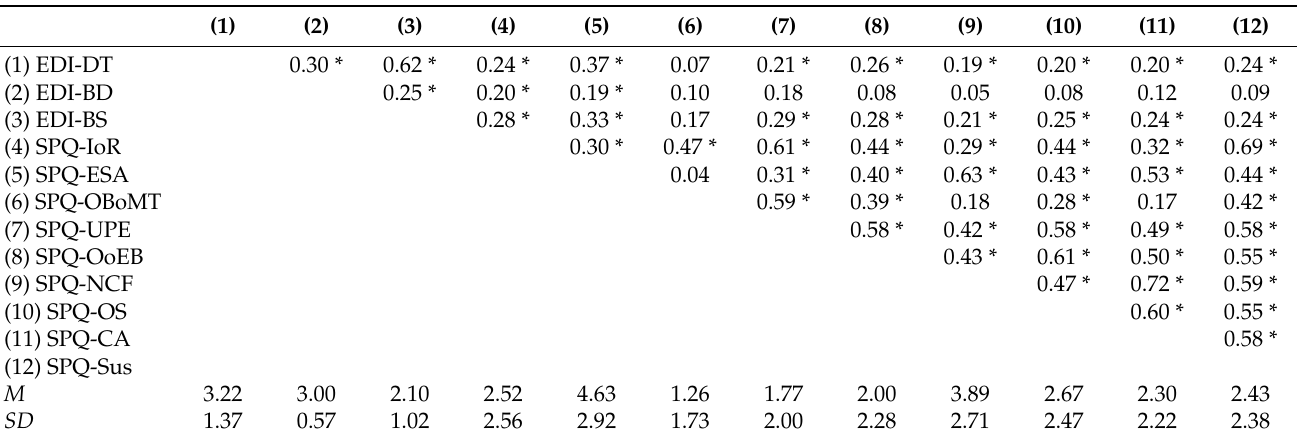
Table 1. Descriptive statistics and bivariate correlations between all variables included in the present